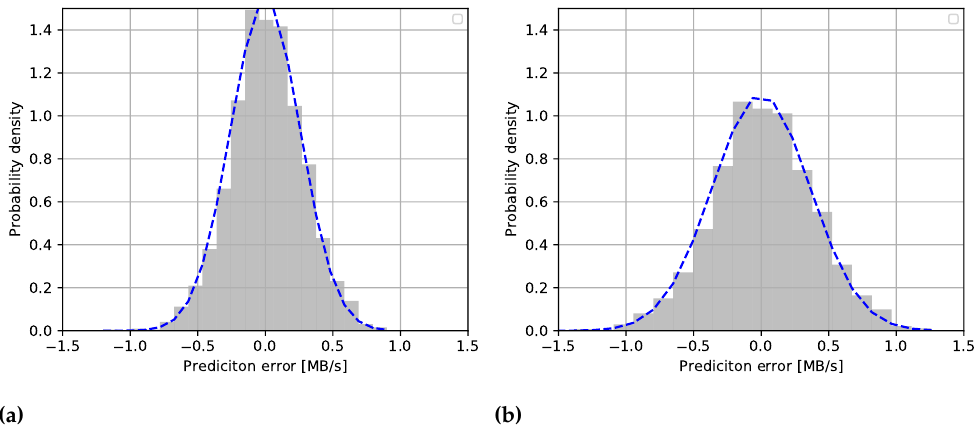
Figure 9. Distribution of prediction errors generated by ( a ) the unidirectional LSTM and ( b ) a simple moving average for the one-step prediction for M5G trace. The narrower prediction error interval for the LSTM ANN indicates fewer errors and better prediction